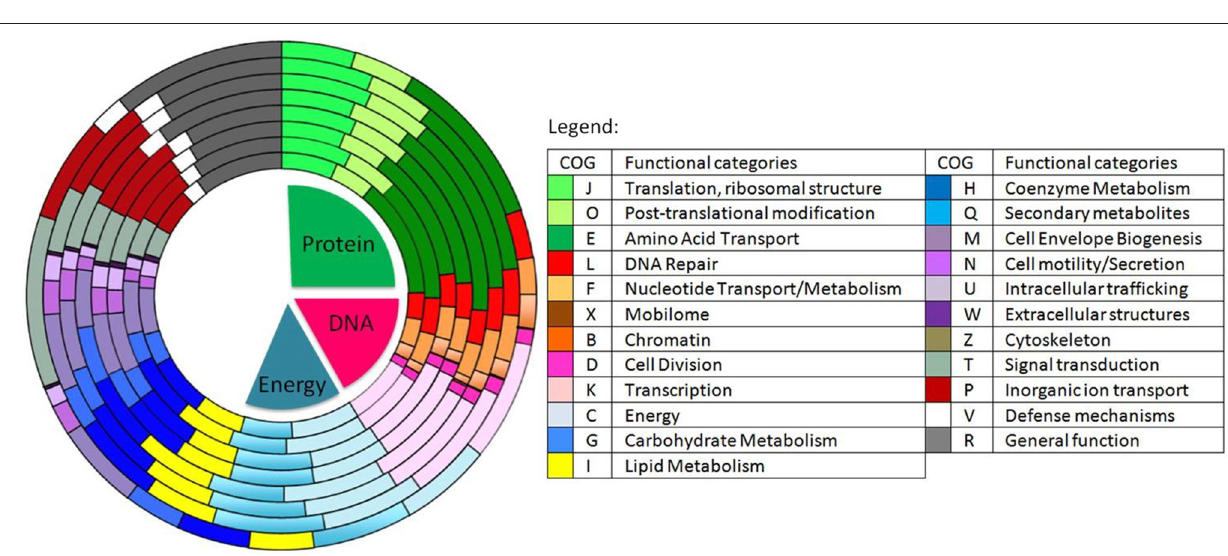
FIGURE 3 | Distribution of the predicted genes into COGs in 8 different species of Ruegeria and Epibacterium . From the innermost to the outermost circle: R. halocynthiae , R. lacuscaerulensis , E. mobile F1926, R. pomeroyi DSS-3, R. TM1040 , R. trichCH4B and our strain E. mobile BBCC367 . Shades of green represent predicted genes involved in protein functions (e.g., amino acid transport), shades of red to purple represent predicted genes involved in DNA processes (e.g., DNA repair) and shades of light blue to yellow represent predicted genes involved in energy metabolism